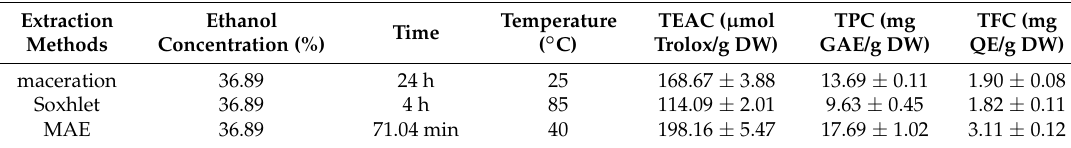
Table 3. The comparison of MAE with conventional